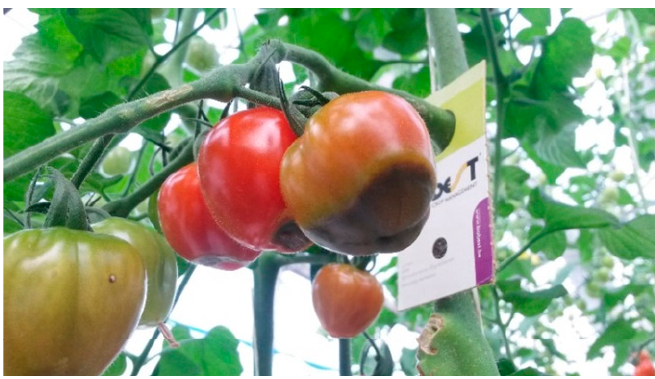
Figure A2. Tomatoes in all hydroponic units affected by blossom ‐ end rot disease at the end of September 2014.